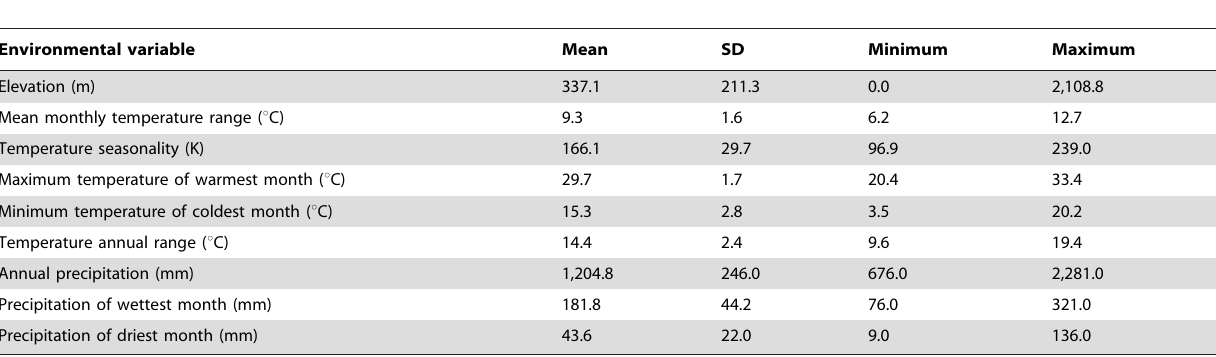
Table 1. Descriptive statistics of each environmental variable from suitable predicted pixels predicted by the binary ensemble model of the potential geographic distribution of the maned sloth ( Bradypus torquatus ).